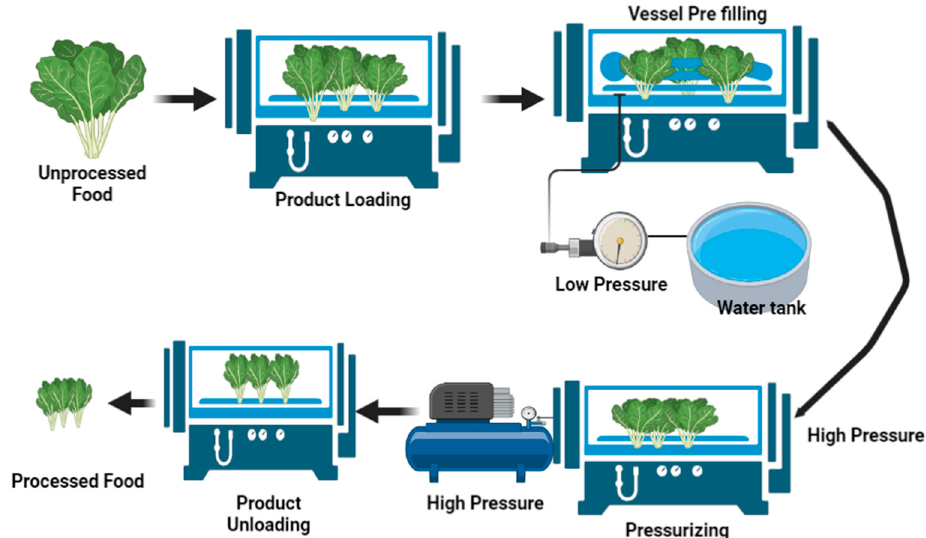
Figure 12. A diagrammatic representation of high hydrostatic pressure